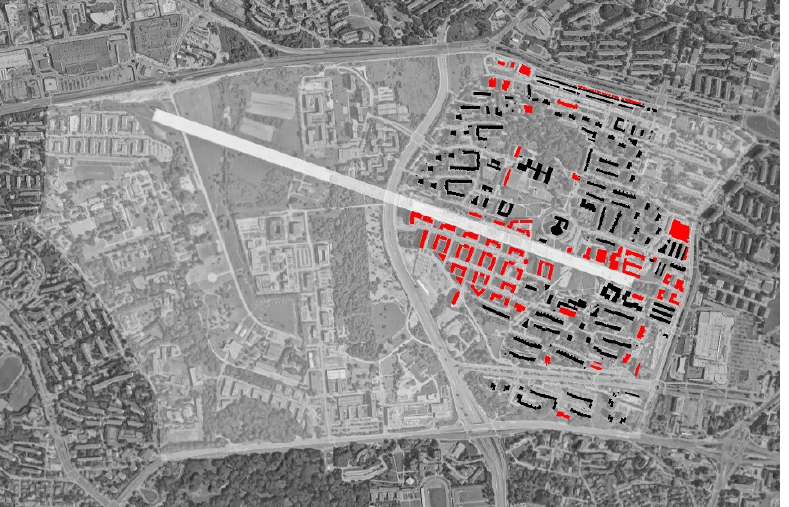
Figure 8. Densifications of housing estates in Czy ż yny in the context of destruction of their main potential—the former runway. Based on an ortophotomap (www.maps.google.com; accessed on 5 December 2021). Color legend: white area—approximate area of the former airport Rakowice- Czy ż yny with a specified runaway (white stripe); black buildings—developments from before 1995 (mostly within the scheme of the construction of the housing estates in Czy ż yny); red—densification— developments from after